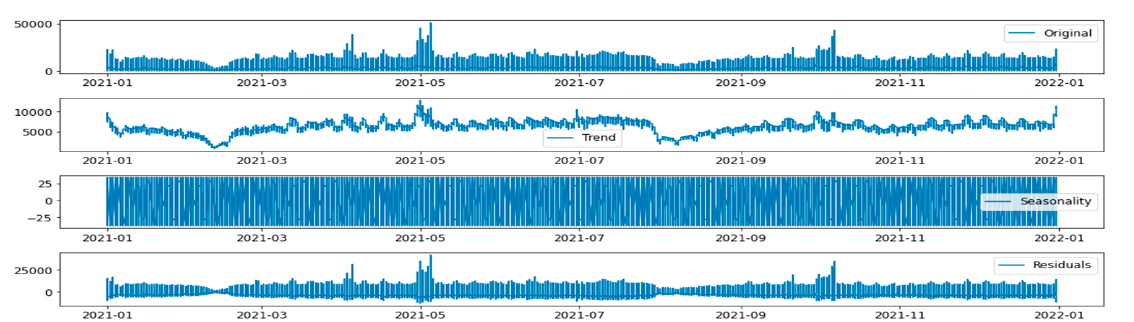
Figure 5. The decomposed plot of the original